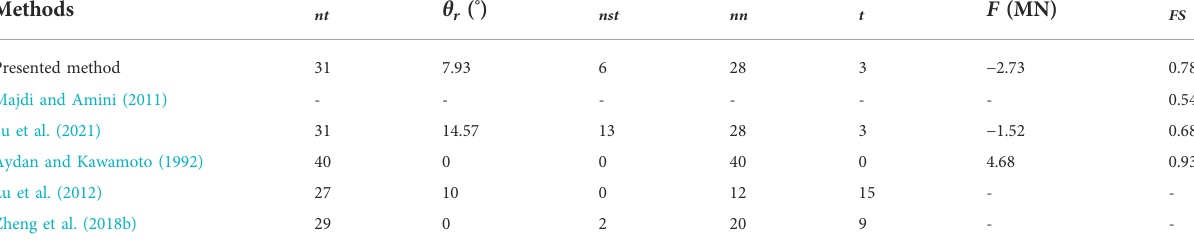
TABLE 3 Results of Yangtai slope calculated using different